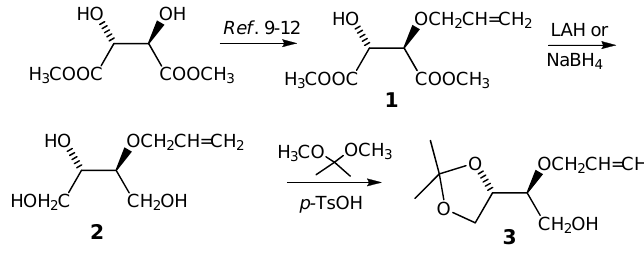
BHO O CH 2 HO O B = uracil,